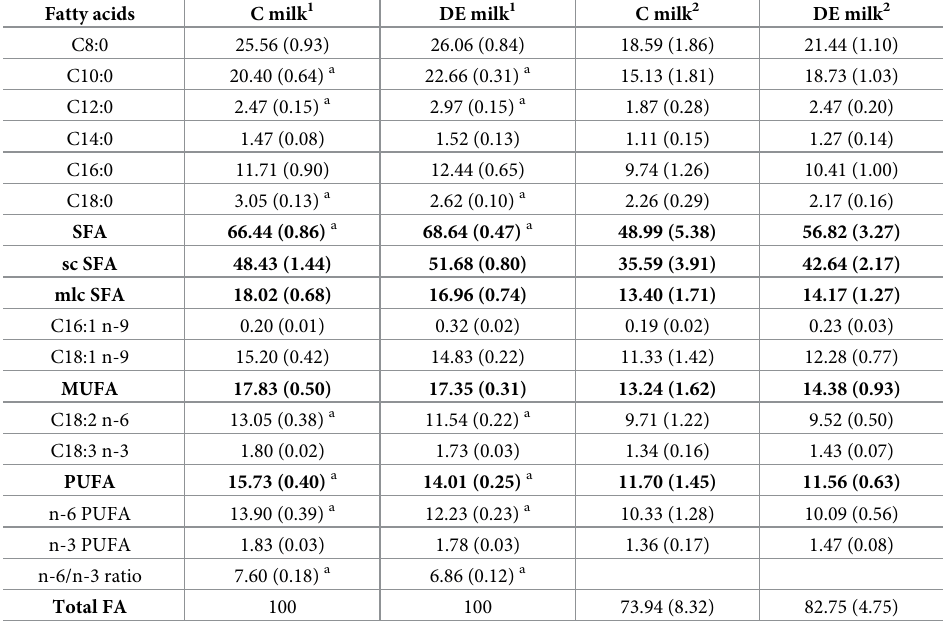
Table 2. Fatty acid composition and content in milk from control (C) and DE-exposed (DE) dams on days 13–16 of lactation. Fatty acids C milk